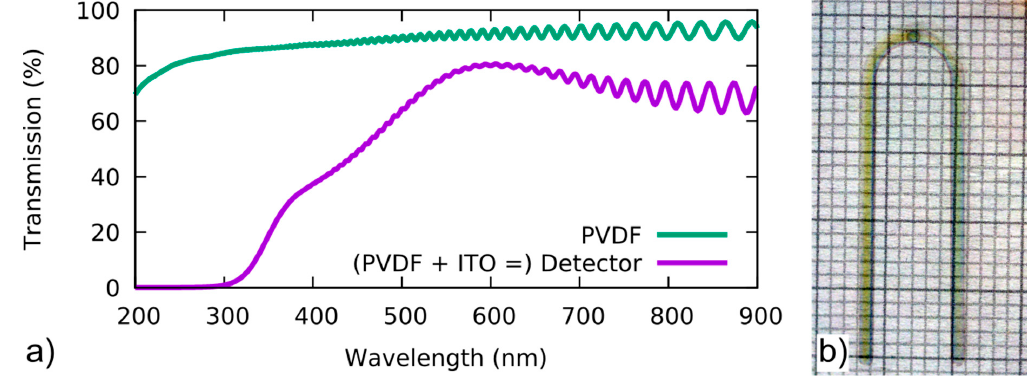
Figure 2. ( a ) Transmission spectra of the polyvinylidene (PVDF) film with and without indium tin oxide (ITO) electrodes. ITO reduces transparency drastically below 400 nm, at 600 nm transmission is highest (80%) and decreases slowly towards higher wavelengths. At 532 nm transmission is still above 70%. Oscillations are due to interferometric effects of the thin film. ( b ) Photo of detector film on scale paper with 1 mm between lines. Contrast is enhanced for visibility. The active area of the detector, where the two electrodes overlap, shows as a slightly darker spot at the apex of the curved electrode